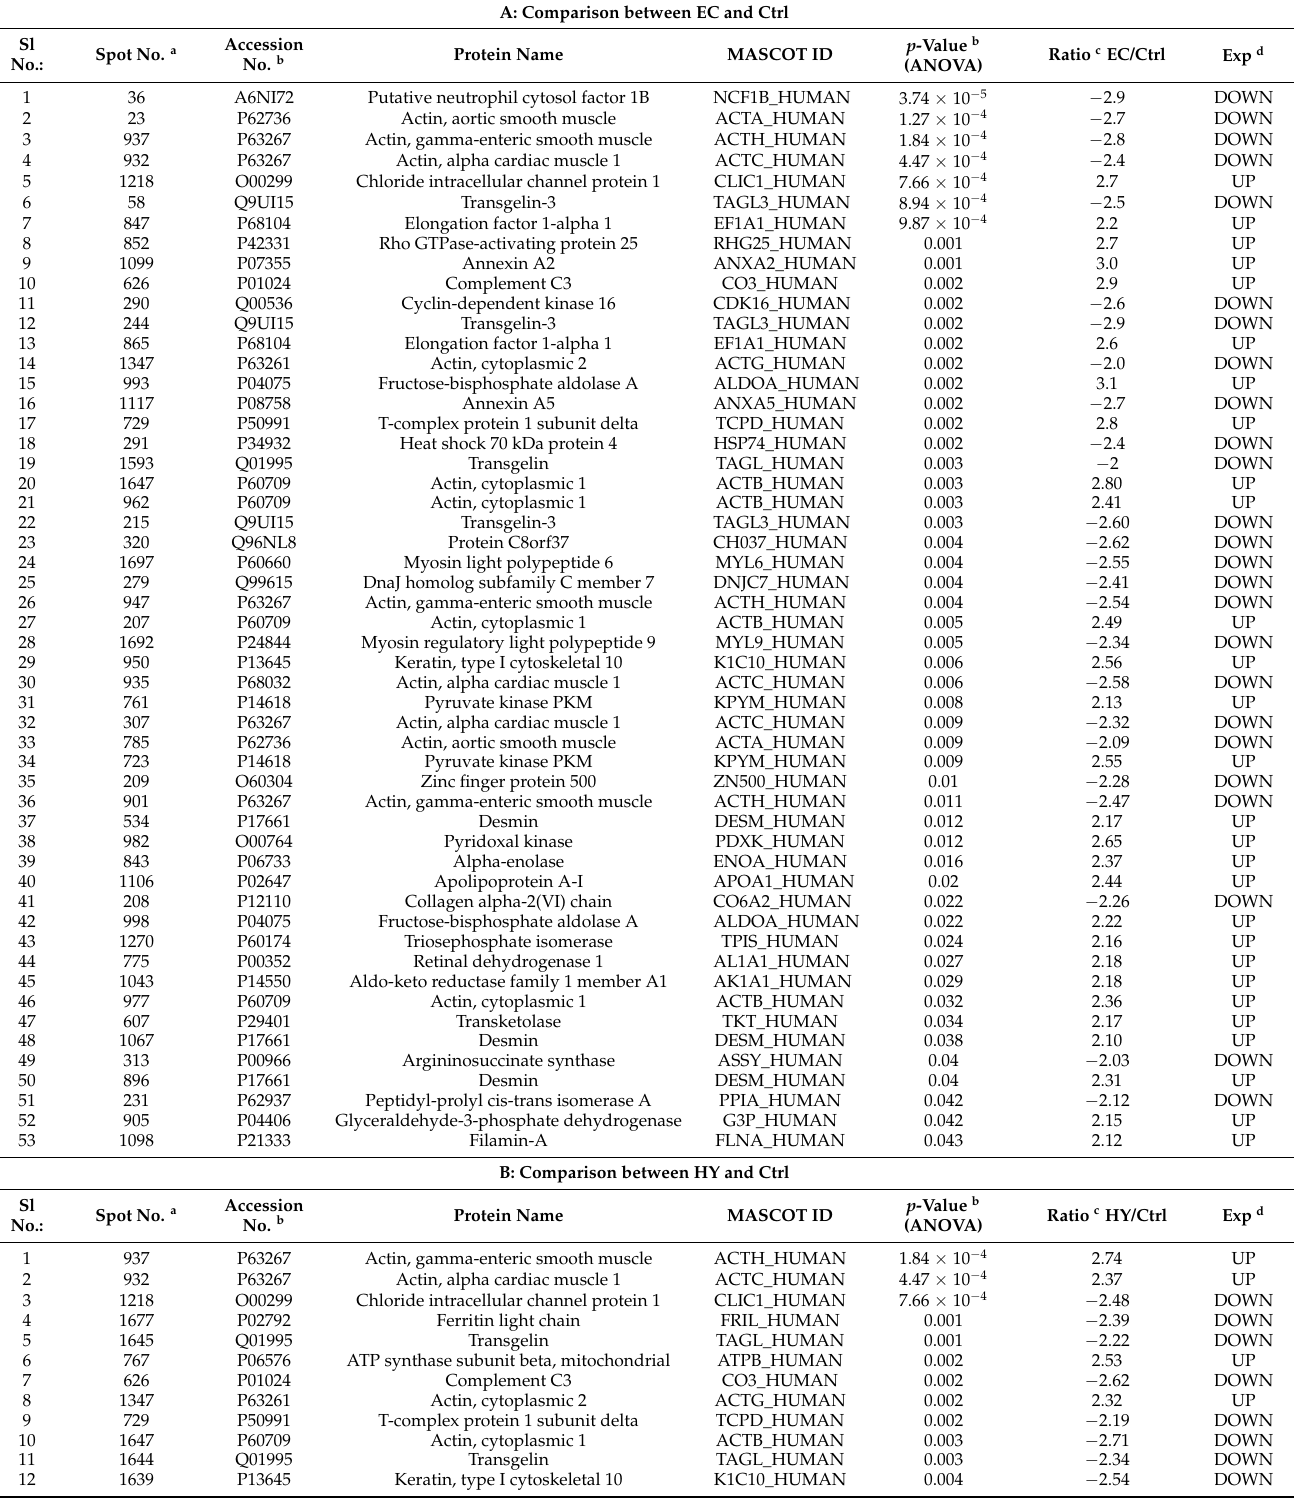
Table 1. Proteins identified with changes in abundance between EC vs. Ctrl (A), HY vs. Ctrl (B) and EC vs. HY (C) in endometrial tissue samples. Values for the average ratio between the two states, fold changes, and one-way ANOVA ( p -value ≤ 0.05) using 2D-DIGE. (Analysis type: MALDI-TOF; database: SwissProt; taxonomy: Homo sapiens , EC: endometrial cancer, HY: hyperplasia, Ctrl: controls.) A: Comparison between EC and